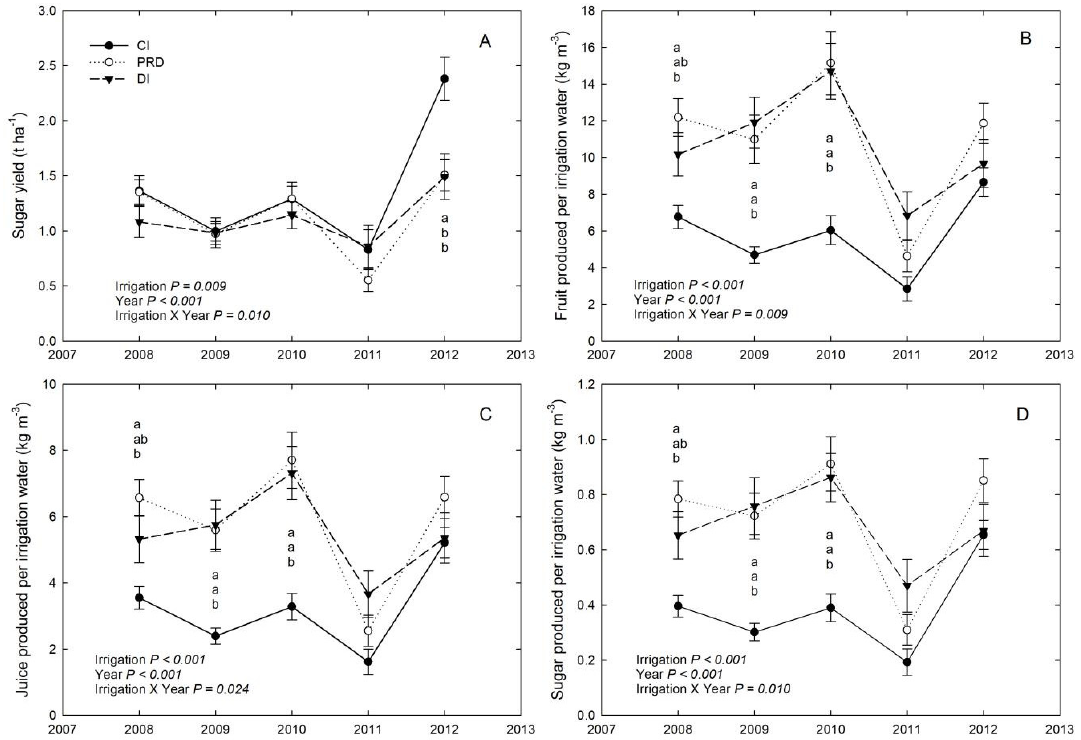
Figure 5. Sugar yield ( A ) and fruit ( B ), juice ( C ), and sugar ( D ) production per unit of irrigation water in adult ‘Valencia’ orange trees under conventional irrigation (CI), partial rootzone drying (PRD), and continuous deficit irrigation (DI) in the five years of observations. Error bars are standard errors of the means. p -values in each panel are for main factors and interactions from the ANOVA models.